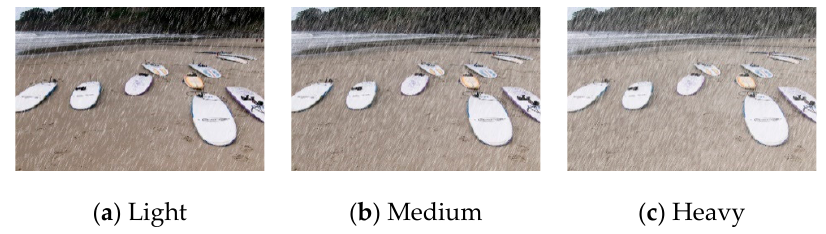
Figure 9. S ynthetic s amples in three different conditions. Figure 9. Synthetic samples in three different conditions.